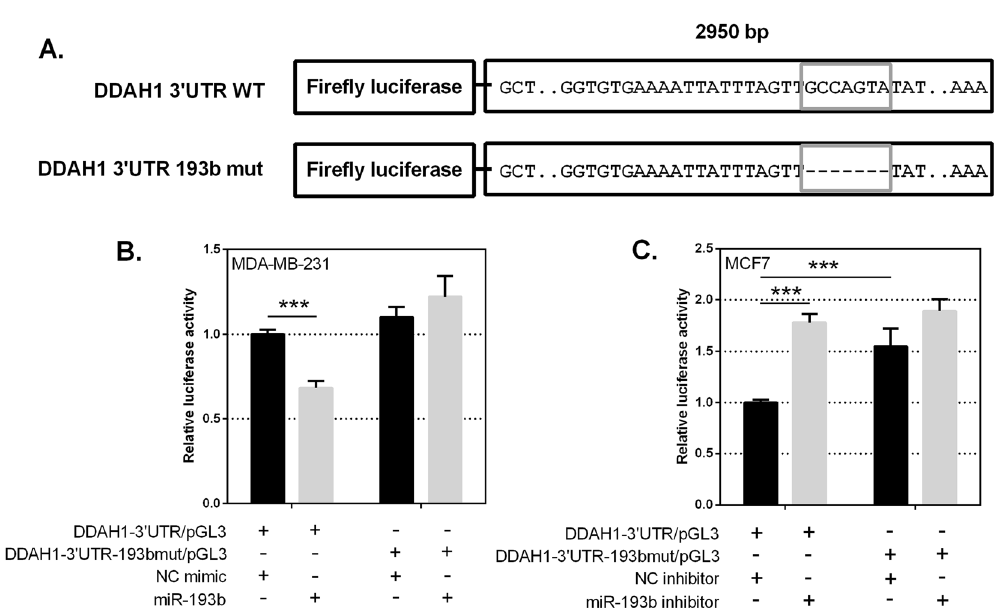
Figure 5. The 3 ′ UTR of DDAH1 is a direct target of miR-193b in MDA-MB-231 and MCF7 cells. Constructs carrying the WT DDAH1 3 ′ UTR or a DDAH1 3 ′ UTR with a deleted miR-193b seed site downstream of a firefly luciferase gene were generated. ( A ) Schematic representation of DDAH1 3 ′ UTR luciferase reporter constructs with WT ( DDAH1 3 ′ UTR WT) or deleted miR-193b seed site ( DDAH1 3 ′ UTR 193b mut). The putative miR-193b seed site is boxed in grey. ( B ) Luciferase analyses in MDA-MB-231 cells. Co-transfection of 30 nM miR-193b mimic reduces DDAH1 3 ′ UTR reporter activity, but not upon deletion of the miR-193b seed site. ( C ) Luciferase analyses in MCF7 cells. Co-transfection of 100 nM miR-193b inhibitor increases DDAH1 3 ′ UTR reporter activity. Deletion of the miR-193b seed site increases basal reporter activity and prevents further activation mediated by miR-193b inhibitors. Luciferase activities were measured 24 hr post transfection and are expressed as the mean firefly/Renilla luciferase ratio relative to that of empty pGL3-promoter vector and normalised to NC mimic or inhibitor transfection, set to a value of 1. Data are the average of at least two independent experiments performed in quadruplicate. Error bars represent SEM. *** p <